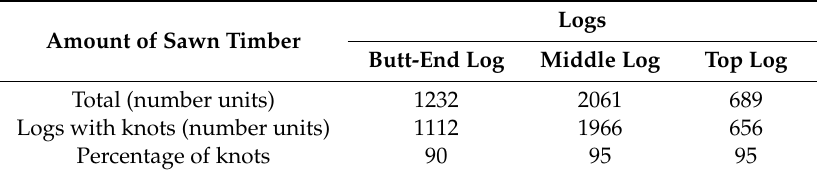
Table 4. The percentage of knots as a factor a ff ecting the quality class of sawn timber in the longitudinal section of long